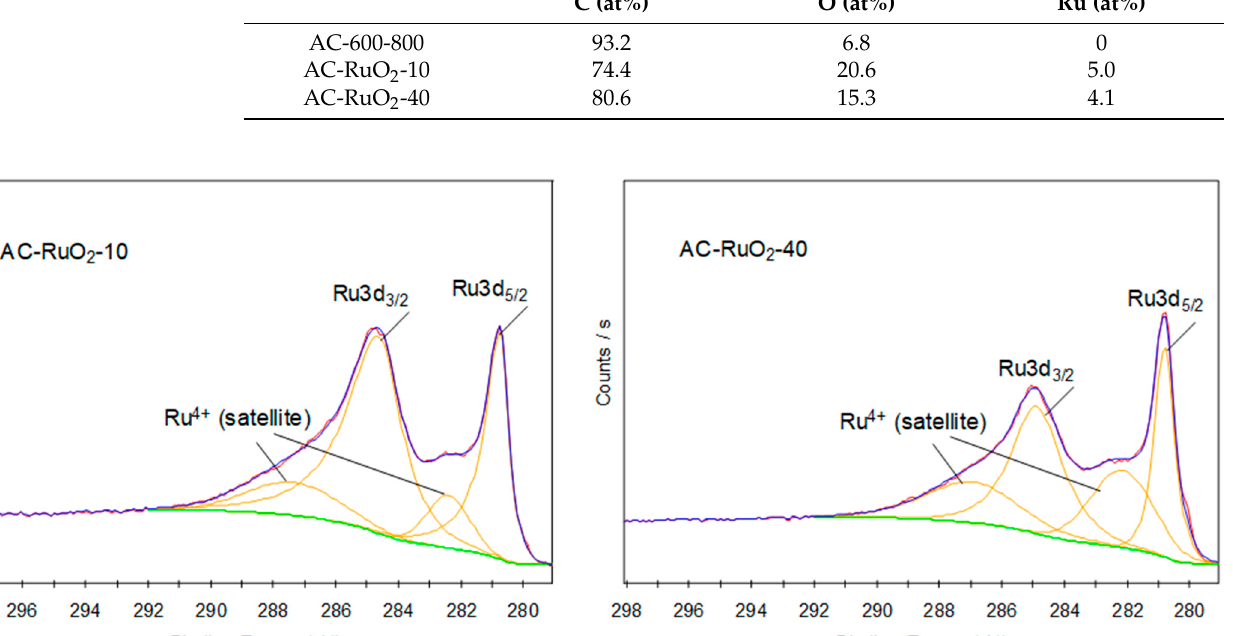
2 -10, and AC-RuO 2 -40.